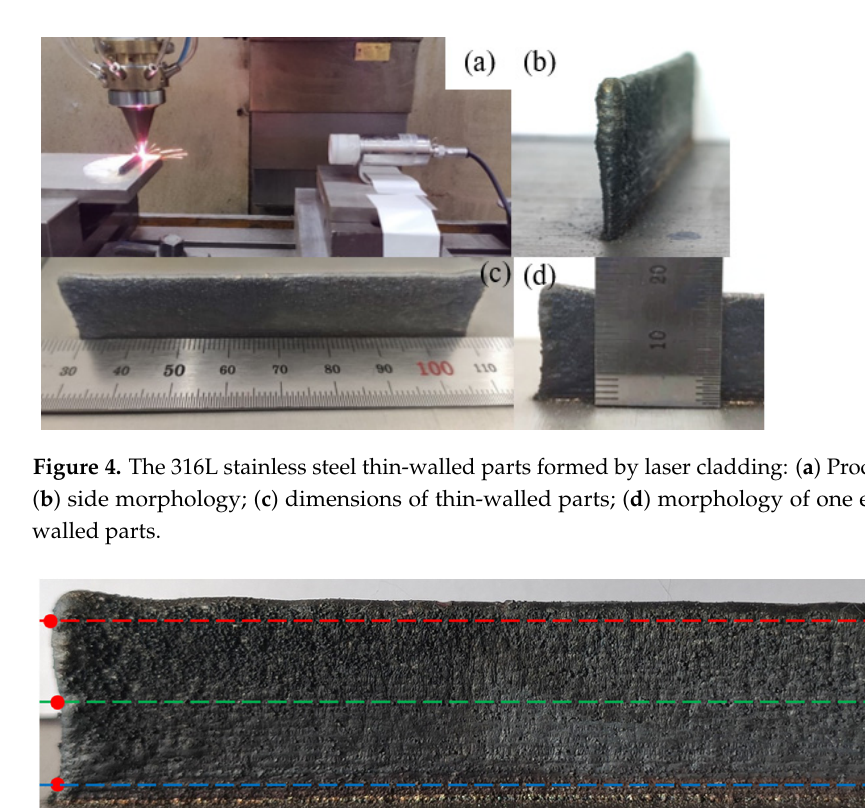
Figure 5. Scanning position and scanning reference point of the laser distance sensor.